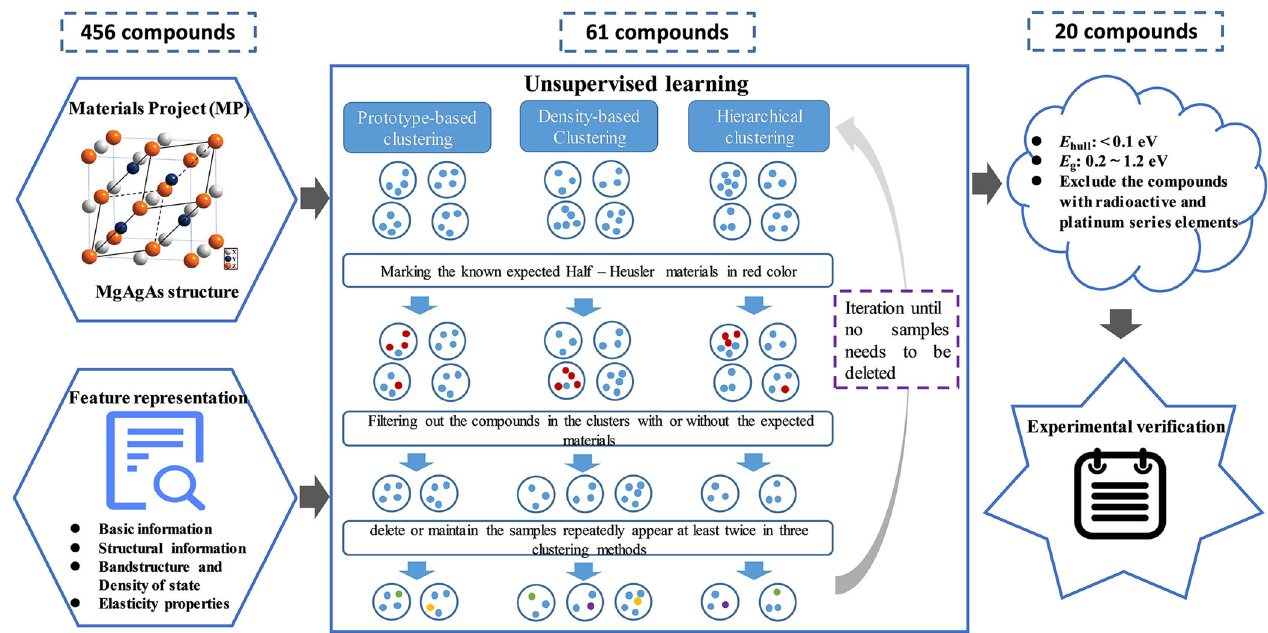
Fig. 8 Work fl ow diagram. The unsupervised machine learning process for the discovery of half-Heusler thermoelectric